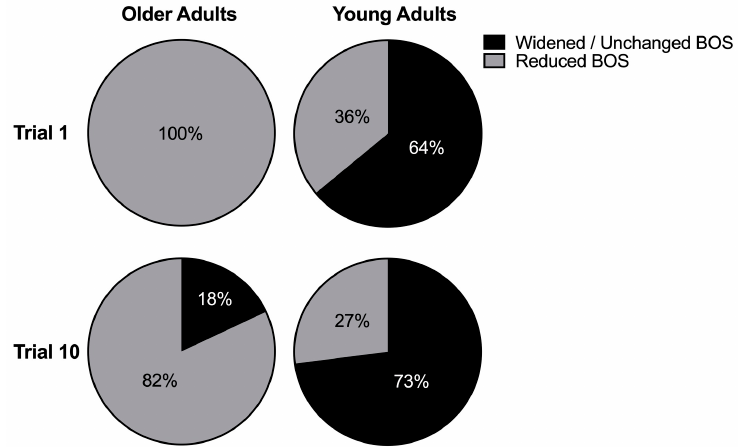
Figure 4 . Percent of narrowed and widened/unchanged base of support following a right step in older and young adults in trial 1 and 10. Narrowed based of support was towards the left and into the direction of the fall and widened or unchanged base of support was towards the right in a counterbalancing direction away from the